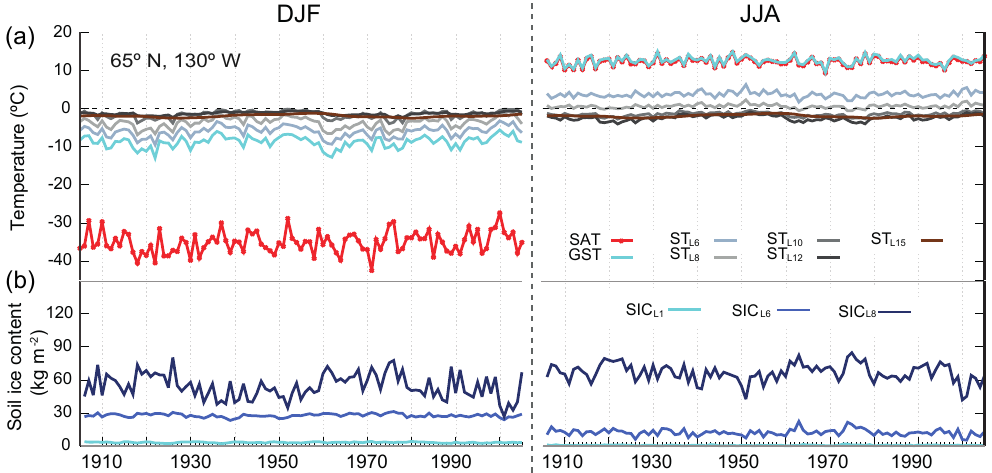
Figure 7. (a) DJF and JJA evolution of SAT, GST, ST L6 , ST L8 , ST L10 , ST L12 and ST L15 during the 1900–2005CE period for a grid point from the ALL- F 2 simulation located in the north of Canada (65 ◦ N,1 30 ◦ W), an area with permanent frozen soils. Dashed lines indicate 0 ◦ C. (b) Soil ice mass content (SIC) in the L1, L6 and L8 soil